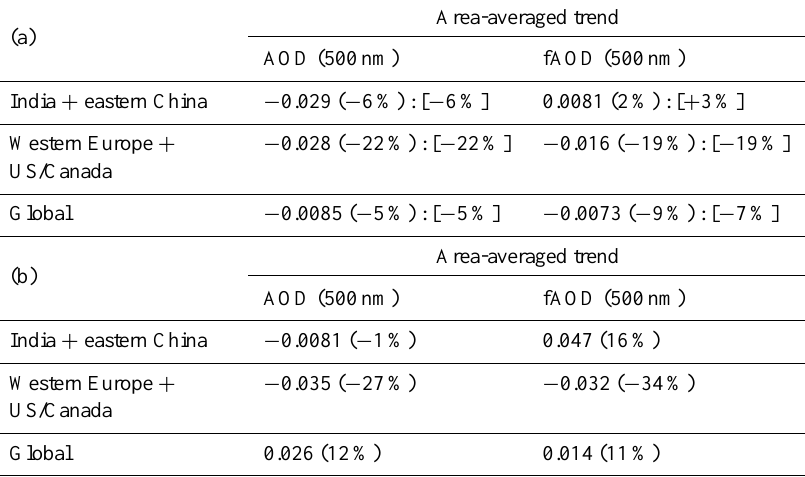
Table 4. Trend from 2001 to 2010 in units of AOD change and AOD percentage change over the 10yr, (a) using our integrated data; and (b) only using AERONET data. The percentage inside of [] is the trend from the integrated data with the temporarily constant AERONET data volume. Linear trend is obtained from annual-mean values for each grid, and then average averages are made. “Eastern China” below refers to the 140–132 ◦ E/24–52 ◦ N portion of China mainland, and “Western Europe” (“US/Canada”) the land part of the Western Europe sector (US/Canada sector) in Fig. 8.